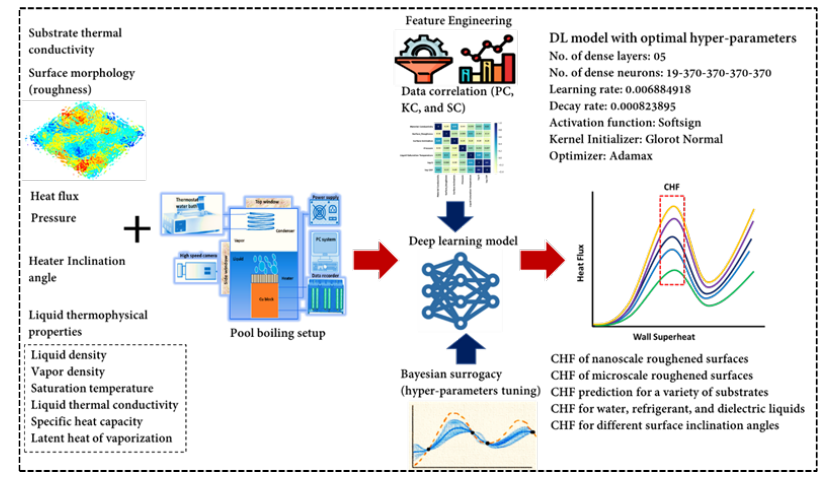
Figure 1. An overview of the research methodology.